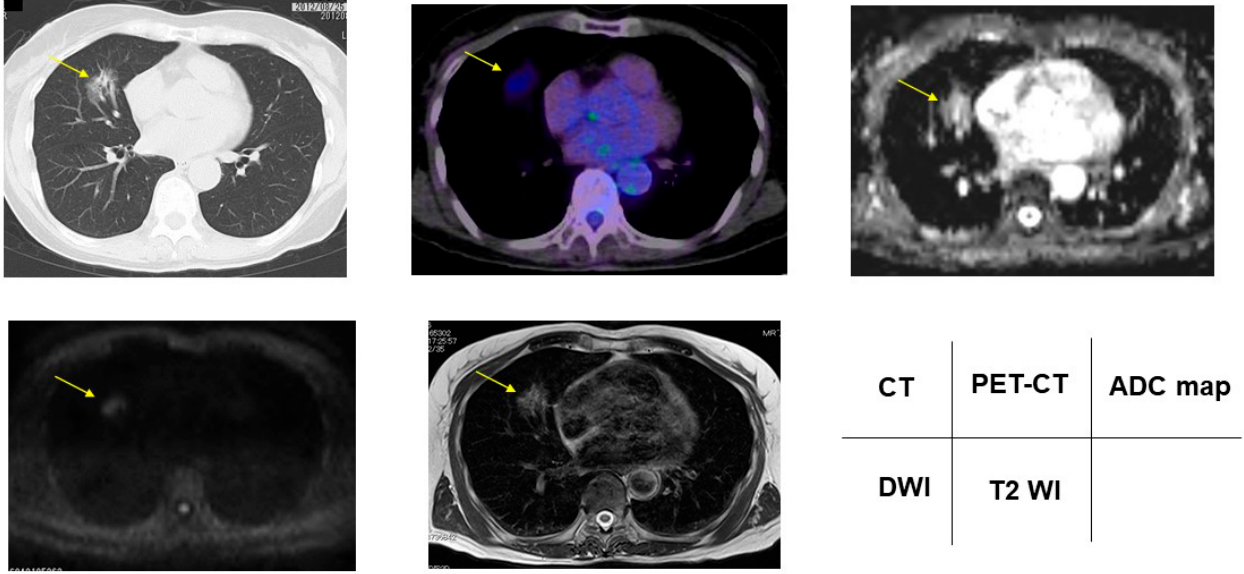
Figure 3. Acinar adenocarcinoma showed 2.17 for SUVmax, DDS 2, 1.67 × 10 − 3 mm 2 /s for ADC, and 1.34 for T2 CR. Yellow arrows shows PNMs.